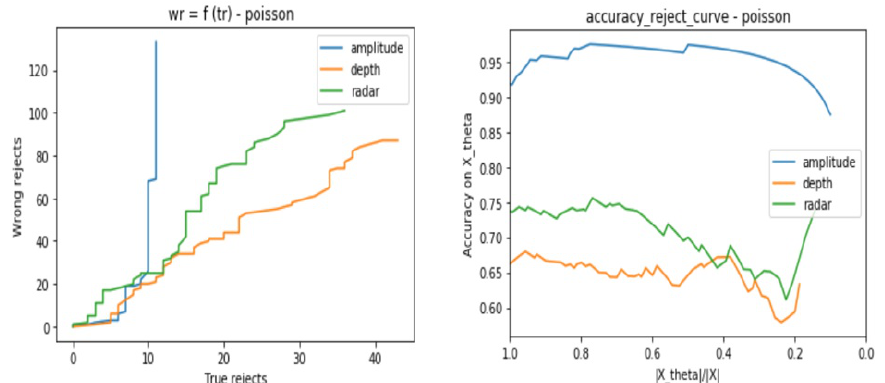
Figure 13. Three classifiers behavior evaluation curves when performing classification with reject option on noisy data sets—considering Speckle noise.